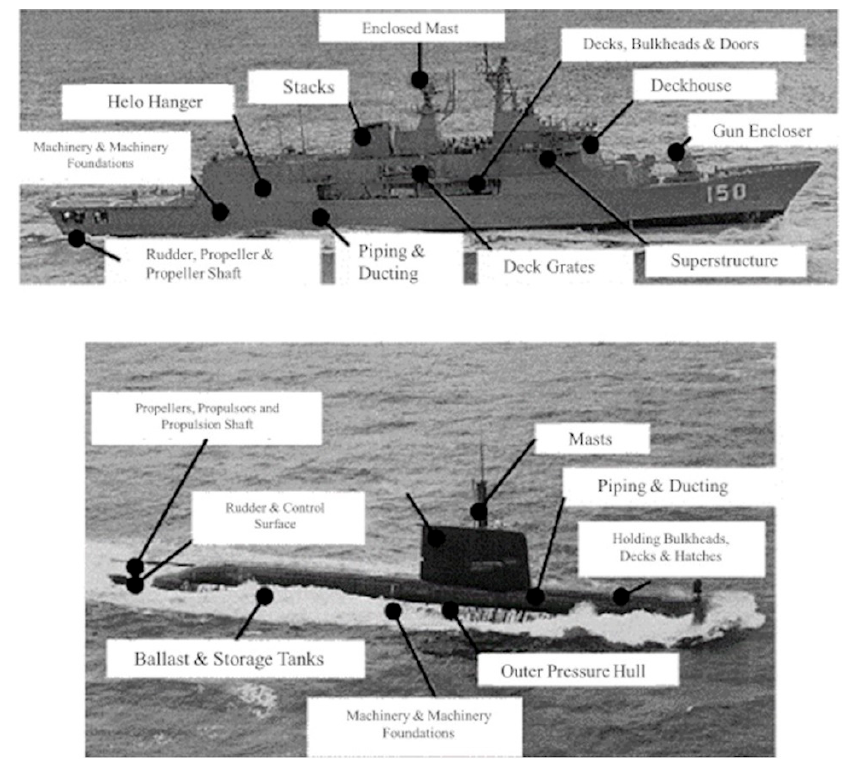
Figure 2. Military applications of fiber-reinforced polymers (FRP) structures to naval ships and submarines